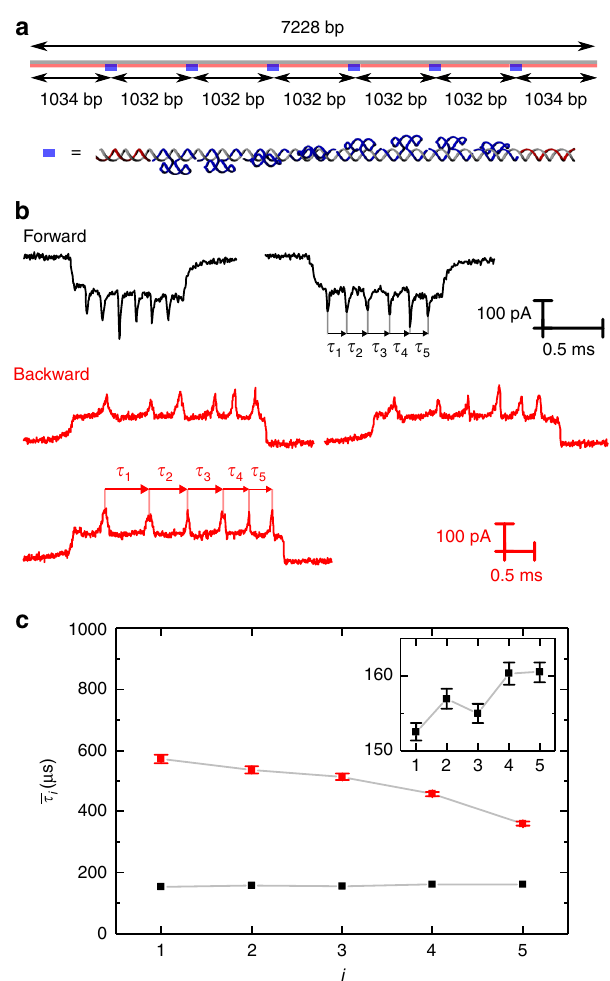
Fig. 4 Intra-event velocity dynamics in forward and backward directions. a Design of construct with six zones containing DNA dumbbell hairpins separated by equal 1032 bp intervals. b Example translocations in the forward and backward directions. The times are measured between peaks as indicated. c Comparison of mean intra-event times in the two directions. Data are shown from a single nanopore ( N = 335 forward and N = 200 backward). Error bars represent standard error of the mean. Grey lines connect the mean values and are used as a guide to the eye. Inset shows the forward direction data with a smaller y -axis range so that the error bars are